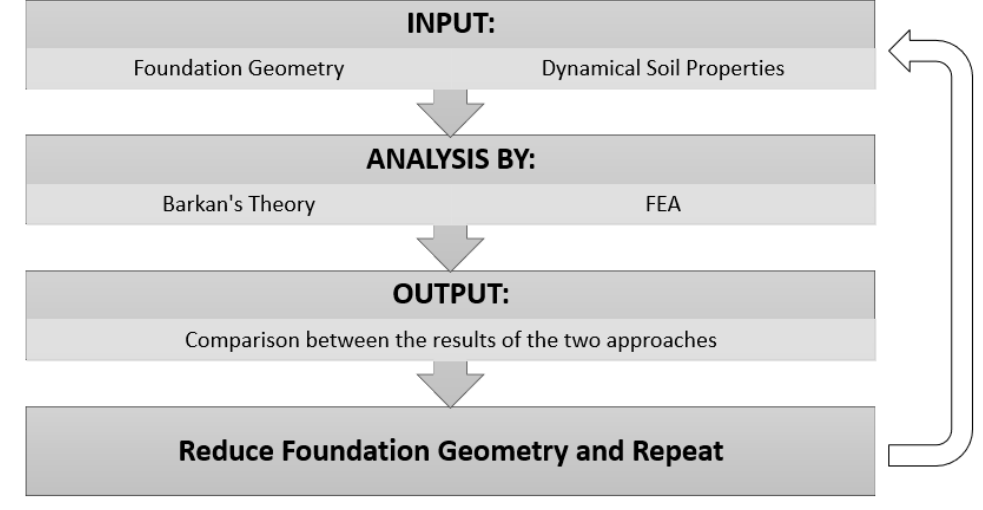
Figure 1. Analysis steps.